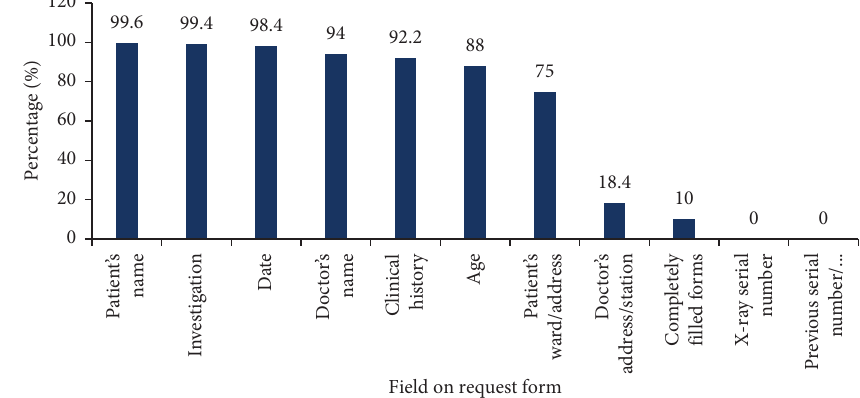
Figure 1: Proportion of forms with fields completely field.